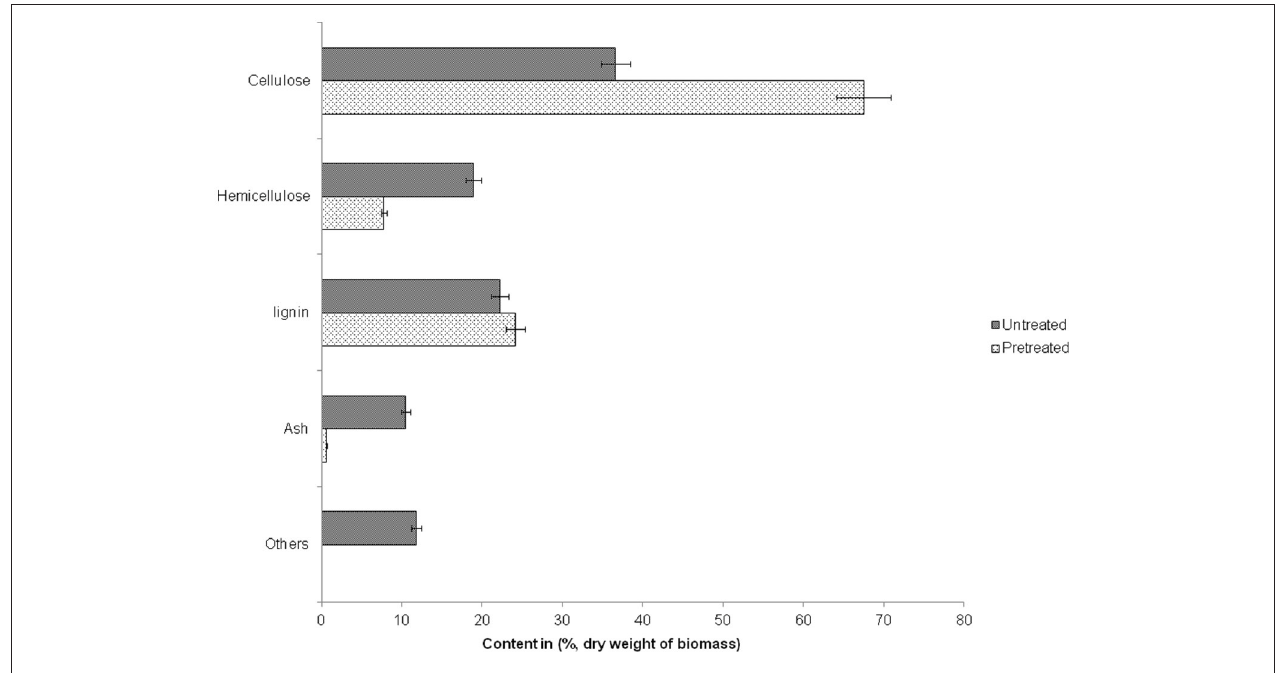
FIGURE 1 | Pretreated and untreated wheat straw composition.